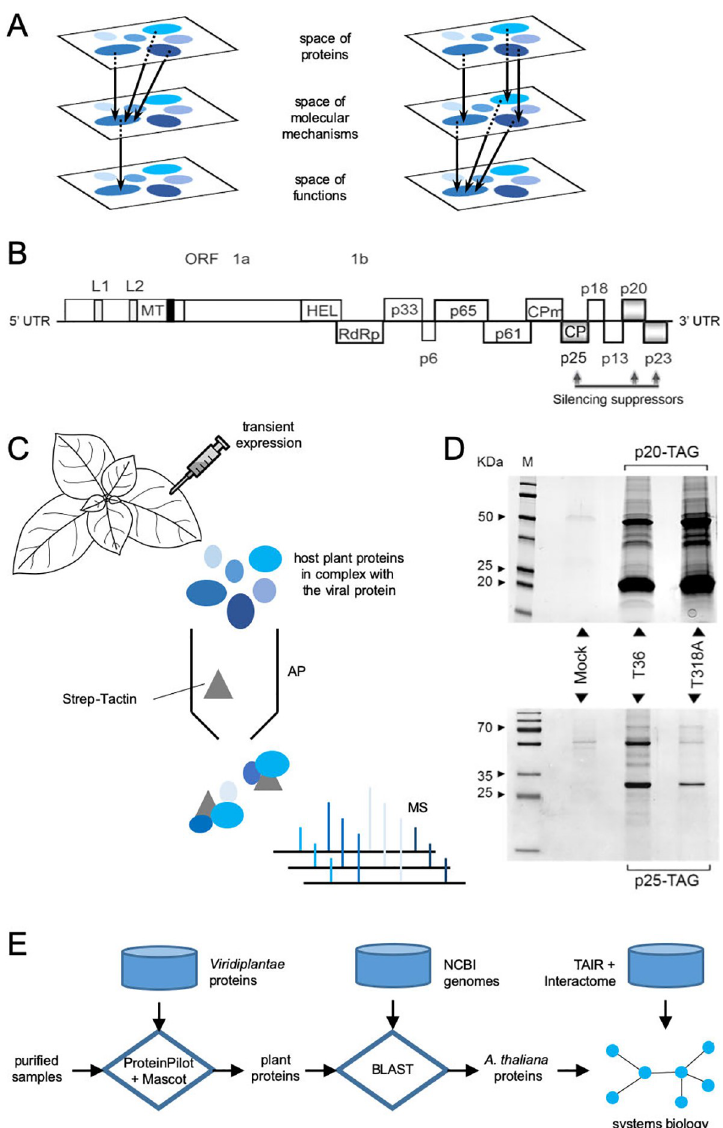
Fig 1. A) Schematic representation of protein function degeneracy. Left: overlap in function accomplished through an overlap in molecular interactions. Right: overlap in function accomplished through different molecular interactions. B) Schematic representation of the genome architecture of CTV. This shows its different proteins, including the two objects of this study (p20 and p25), which are two known suppressors of RNA silencing. C) Schematic representation of the adopted experimental framework: affinity purification (AP) followed by mass spectrometry (MS) from transient expression in plants of the viral protein of interest tagged with the Twin-Strep-tag. D) Electrophoretic assay